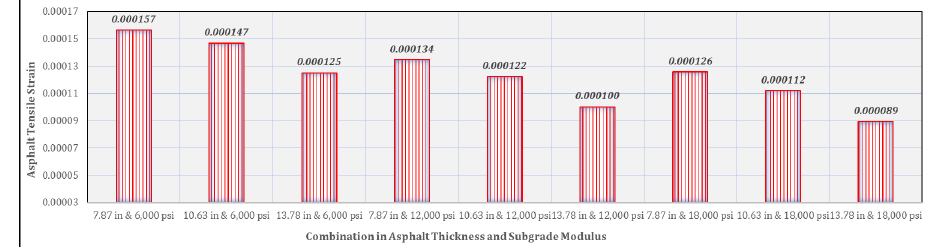
Figure 31: Influence of subgrade modulus and asphalt thickness on asphalt tensile strain in asphaltic overlayment rail track.